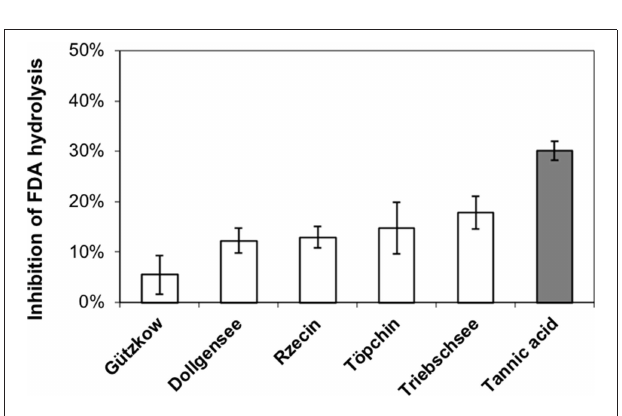
FIGURE 6 | Inhibition of fluorescein diacetate (FDA) hydrolysis in highly decomposed peat from rewetted peatland “Zarnekow” using isolated tannins from less decomposed peat of pristine peatlands (white bars) and commercial tannic acid standard (gray bar). inhibition tests with 100 mg tannins L − 1 were below saturation point ( Figure 7 ).